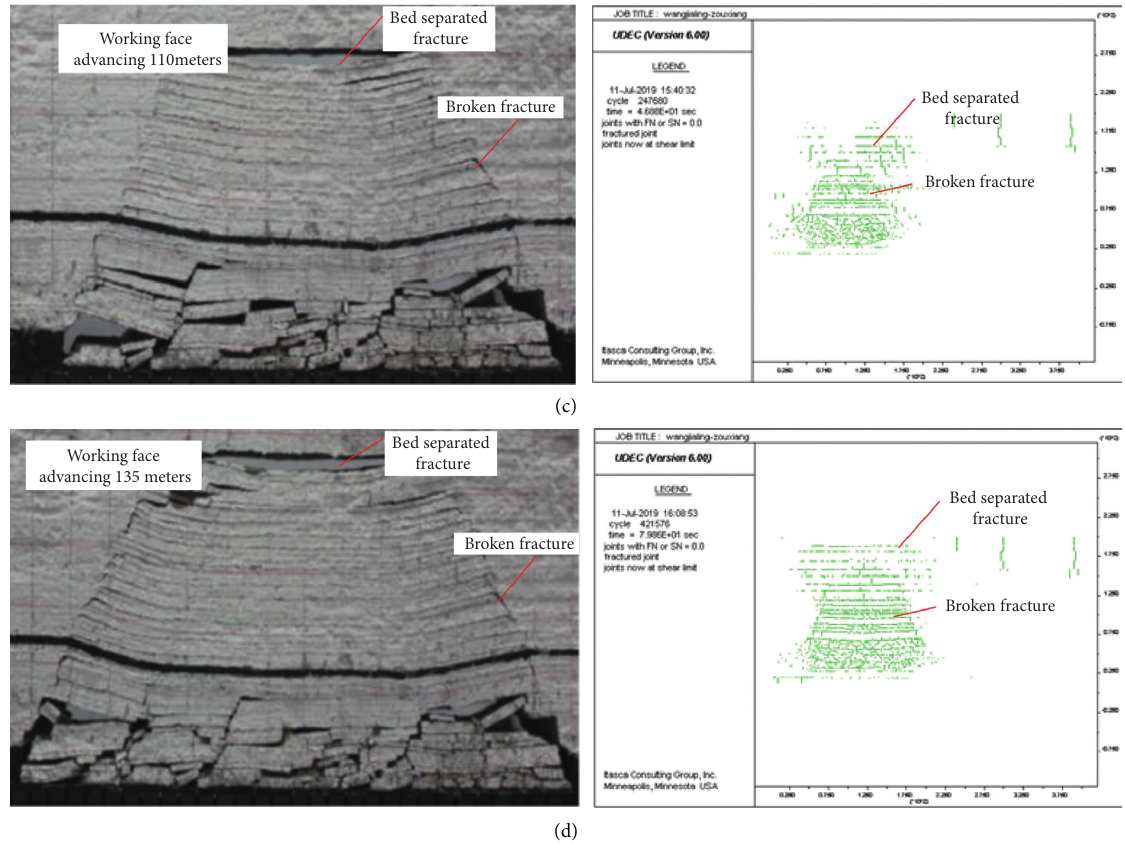
Figure 2: Simulation of overlying strata structure and fracture evolution in the early stage of mining. (a) First weighting of working face. (b) First periodic weighting of working face. (c) Second periodic weighting of working face. (d) Third periodic weighting of working face.